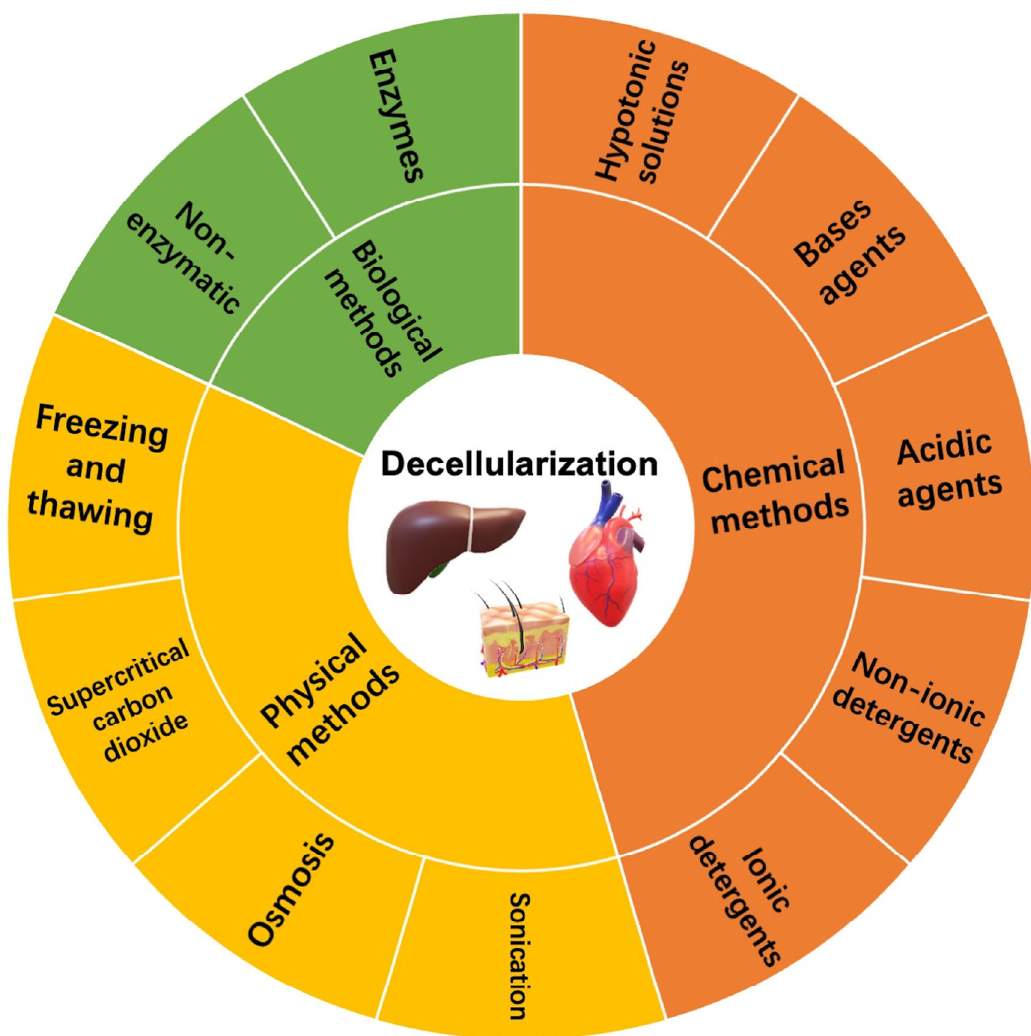
Figure 4. The common decellularization methods.